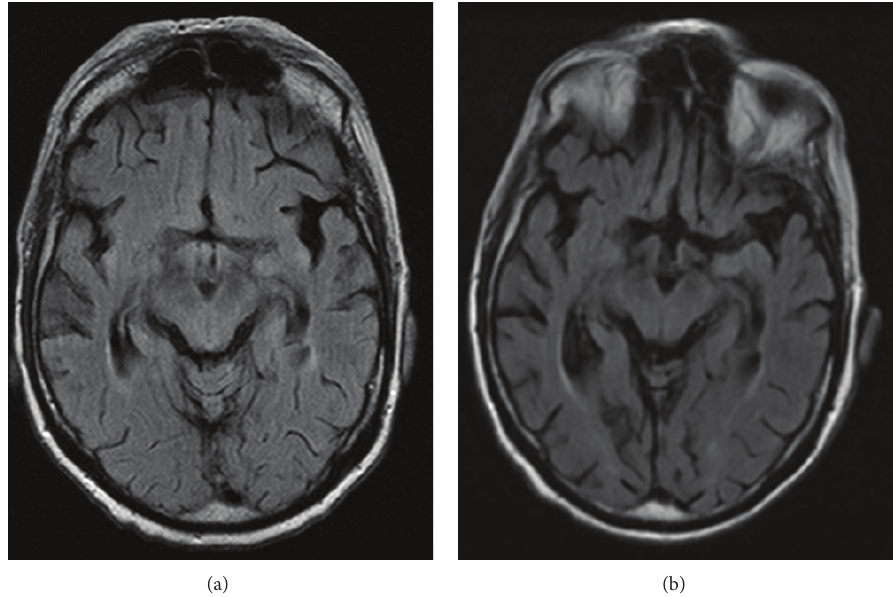
Figure 1: Axial FLAIR images obtained before initiation of Rituximab. Normal anatomy and signal intensity of limbic system were seen at initial presentation as well as after longer course of disease (left: November 2007; right: February